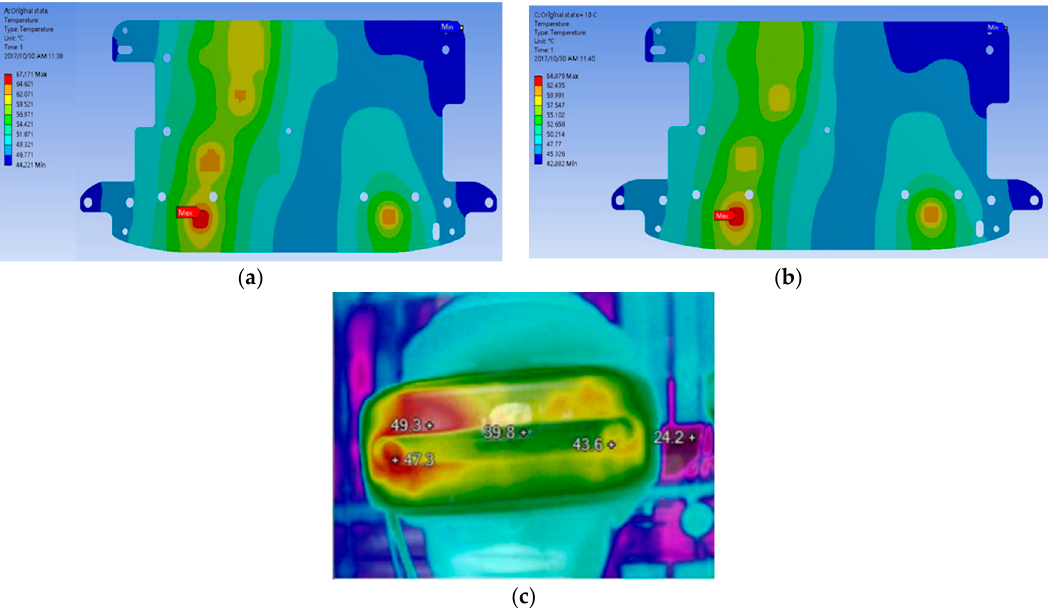
Figure 12. Temperature fields of the PCBA within the VR device. ( a ) Original temperature field of PCBA within the VR device. ( b ) Temperature field of VR PCBA after pasting graphene TIM (MSA0095). ( c ) Thermal imaging temperature field of VR PCBA after pasting graphene TIM (MSA0095).